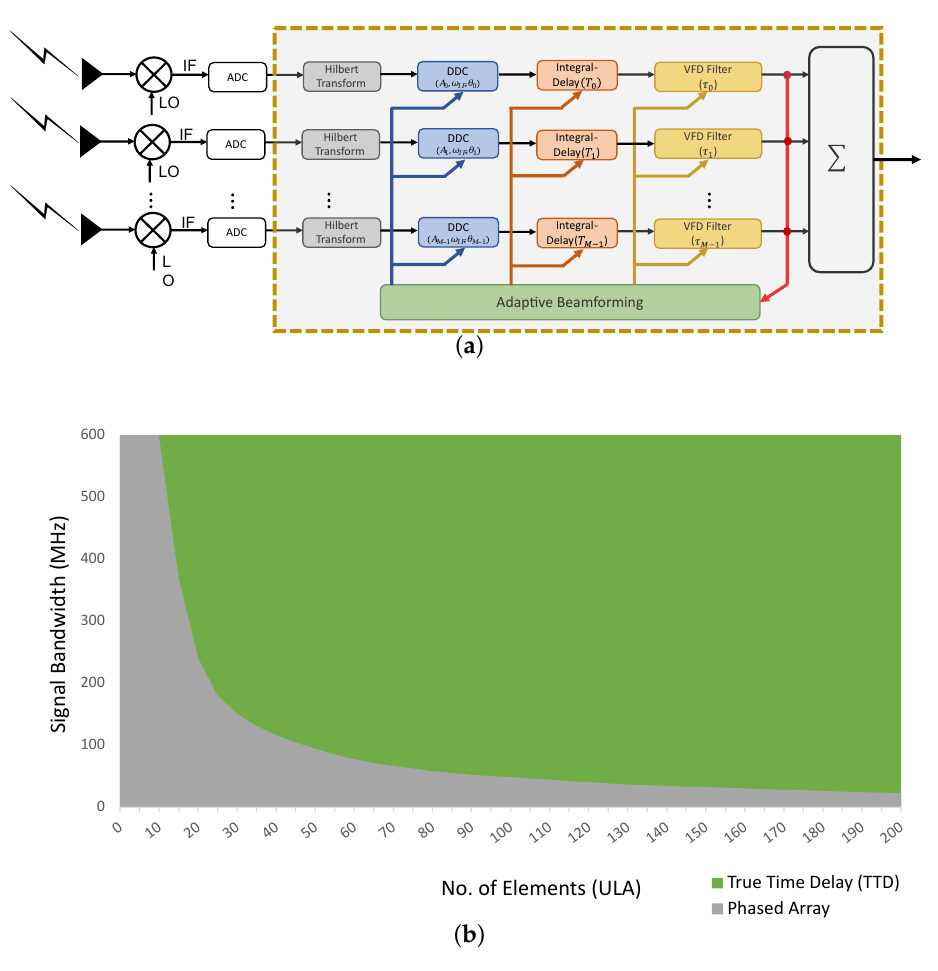
Figure 1. ( a ) Architecture of typical TTD-based wideband large-scale antenna systems (TTD—True Time Delay; ADC—Analog-to-Digital Converter; DDC—Digital Down-Converter; VFD—Variable Fractional Delay); ( b ) maximal signal bandwidth vs. number of elements